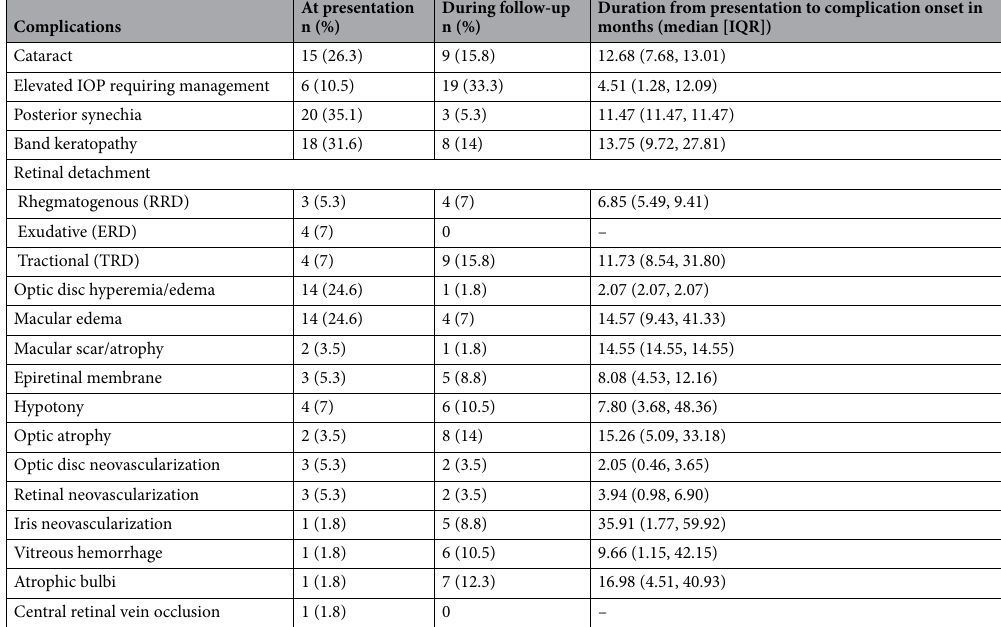
Table 3. Ocular complications at presentation and during follow-up. ERD exudative retinal detachment, IOP intraocular pressure, IQR interquartile range, RRD rhegmatogenous retinal detachment, TRD tractional retinal